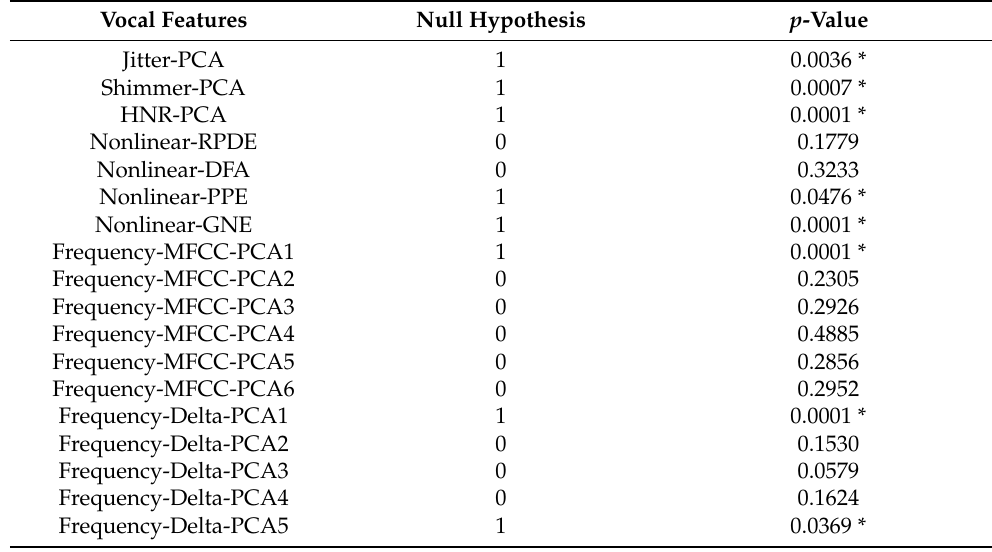
Table 3. Mann–Whitney–Wilcoxon hypothesis test results of the vocal features derived from the PCA approach. The p -value < 0.05 indicates the significant difference, marked with * . Null hypothesis: Data samples from two subject groups are not significantly different in statistical sense; 1: rejects the null hypothesis, with the corresponding p -value marked with stars, 0: accepts the null